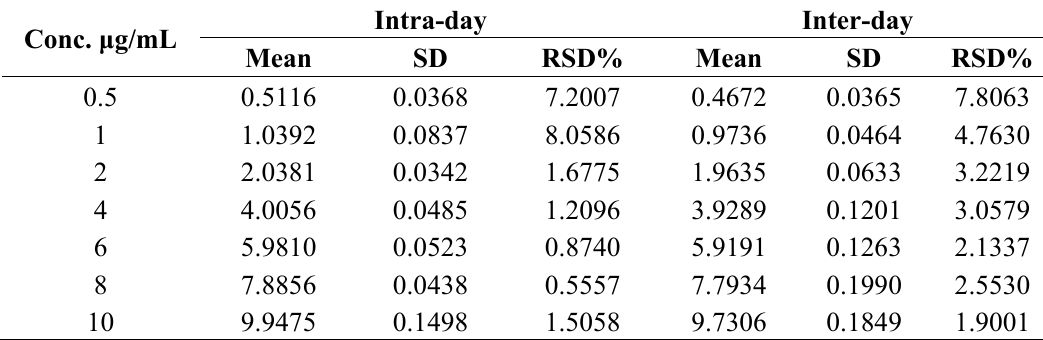
Table 1. HPLC method precision evaluation, the repeatability (intra-day) and intermediate precision (inter-day) represented by SD and RSD% (standard deviation and the relative standard deviation) for a series of